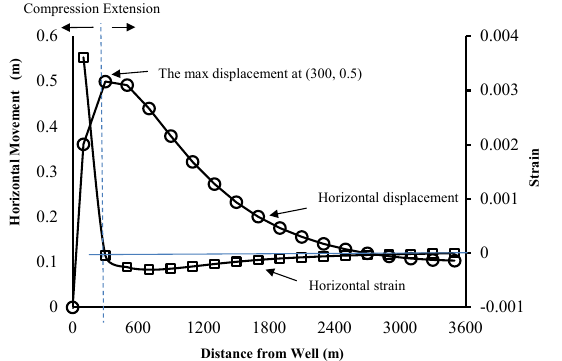
Figure 5. Horizontal movement and strain in Layer 7 after 100 days pumping.